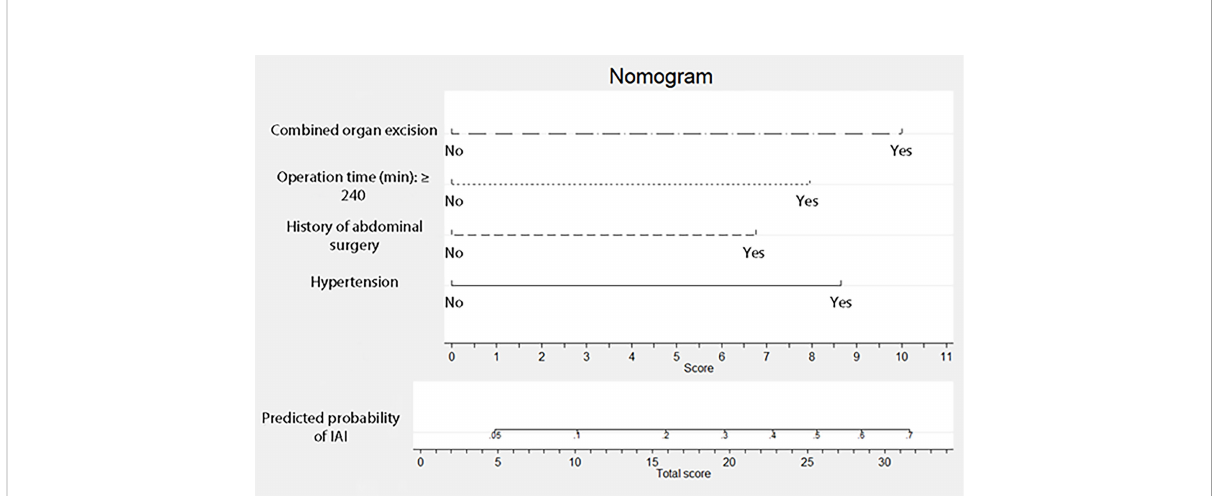
FIGURE 4 Nomogram for intra-abdominal infection after surgery for gastric cancer. To estimate the probability of intra-abdominal infection, mark patient values at each axis, draw a straight line perpendicular to the point axis, and sum the points for all variables. Next, mark the sum on the total point axis and draw a straight line perpendicular to the probability axis.